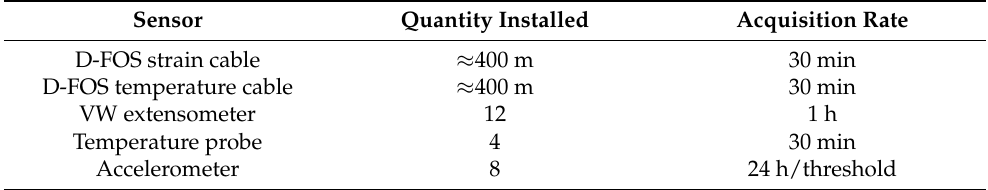
Table 1. Sensors installed on the